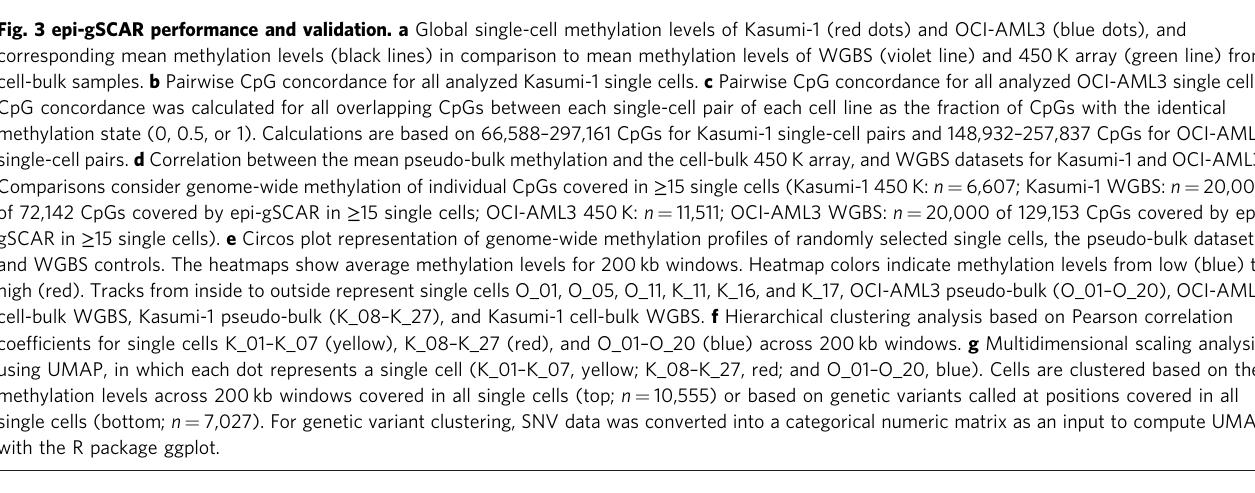
single cells (bottom; n = 7,027). For genetic variant clustering, SNV data was converted into a categorical numeric matrix as an input to compute